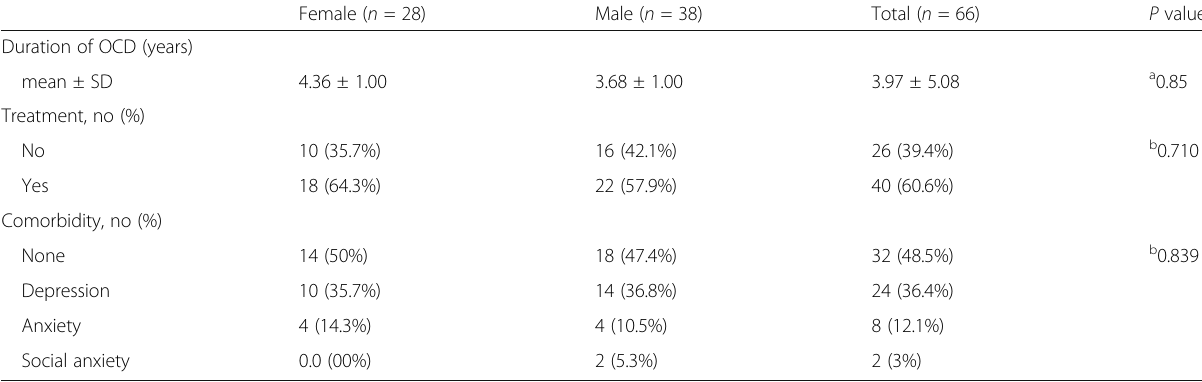
Table 2 Clinical characteristics of the OCD group ( n =